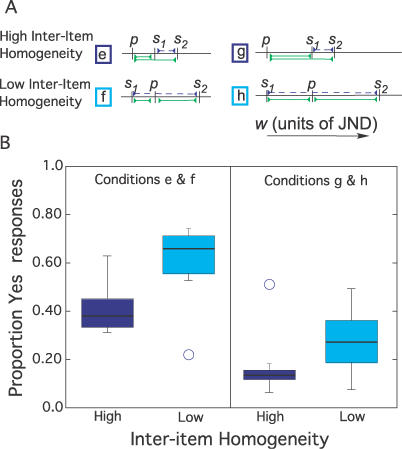
Effect of Inter-Item Similarity(A) A schematic diagram of four stimulus conditions. These examine effects of inter-item homogeneity on participants' report of having seen a stimulus. Conditions e & f keep summed probe-item similarity constant (indicated by the total length of green bars for each condition) while changing inter-item homogeneity (length of blue dashed bar). Conditions g & h do the same, but for a different summed probe-item similarity. These diagrams show the relationships between conditions, rather than the actual values stimuli may take. As in all figures, inter-item similarity is denoted in shades of blue, whereas summed probe-item similarity is in green.(B) The results of the experiment. For each pair of otherwise matched stimuli, when stimulus items are more homogeneous (dark blue), participants are less likely to indicate that a probe has been seen before than if the stimulus items are less homogeneous (light blue) (p < 0.01). Box and whisker plot conventions are as described in the caption for Figure 5B.